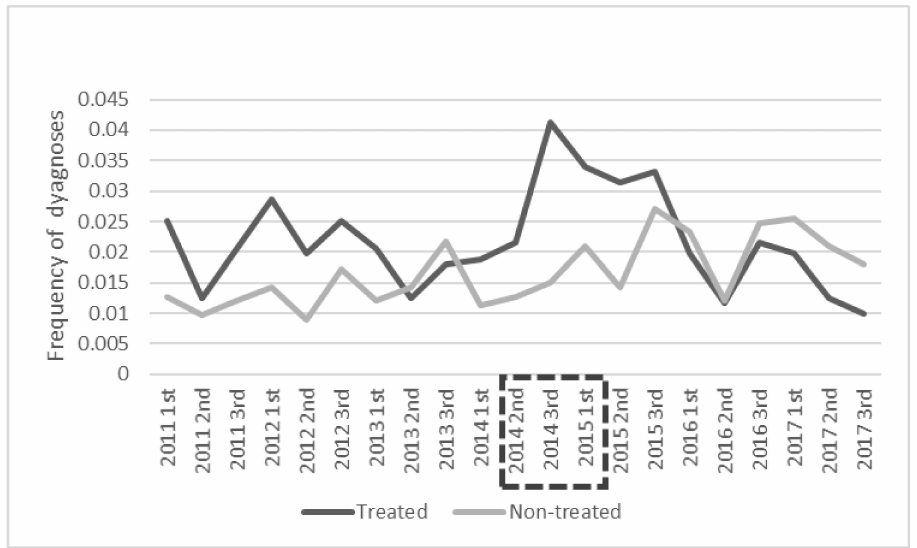
Figure A2. Time-trend frequency of all asthma diagnoses compared by group; The circled area indicates the intervention